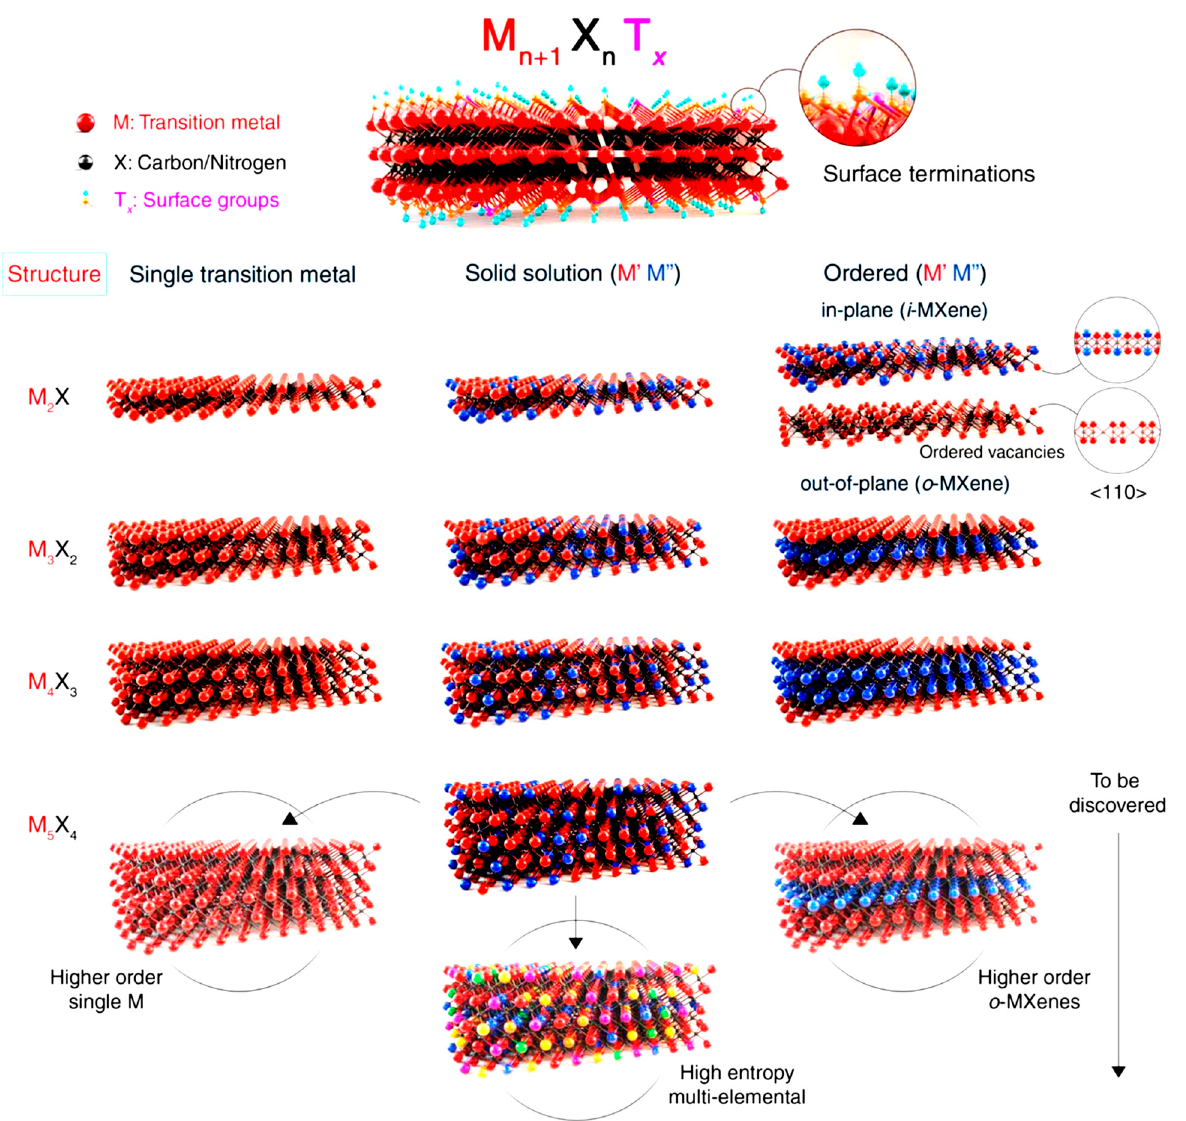
Figure 3. Schematic of MXenes with different n values, such as Ti 2 CT x (n = 1), Ti 3 C 2 T x (n = 2), Nb 4 C 3 T x (n = 3), and (Mo,V) 5 C 4 T x (n = 4). Reprinted with permission from Ref. [17].